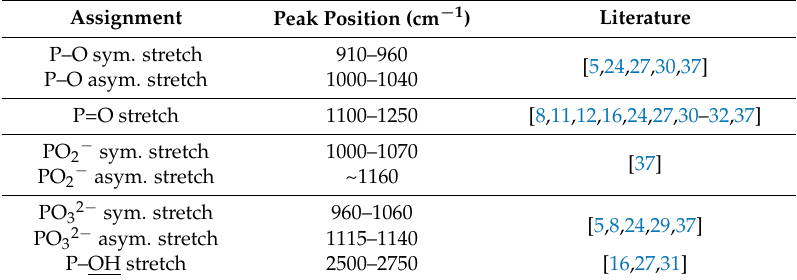
Infrared vibrational modes involving the phosphorus atom for the self-assembled organophosphorus layer on